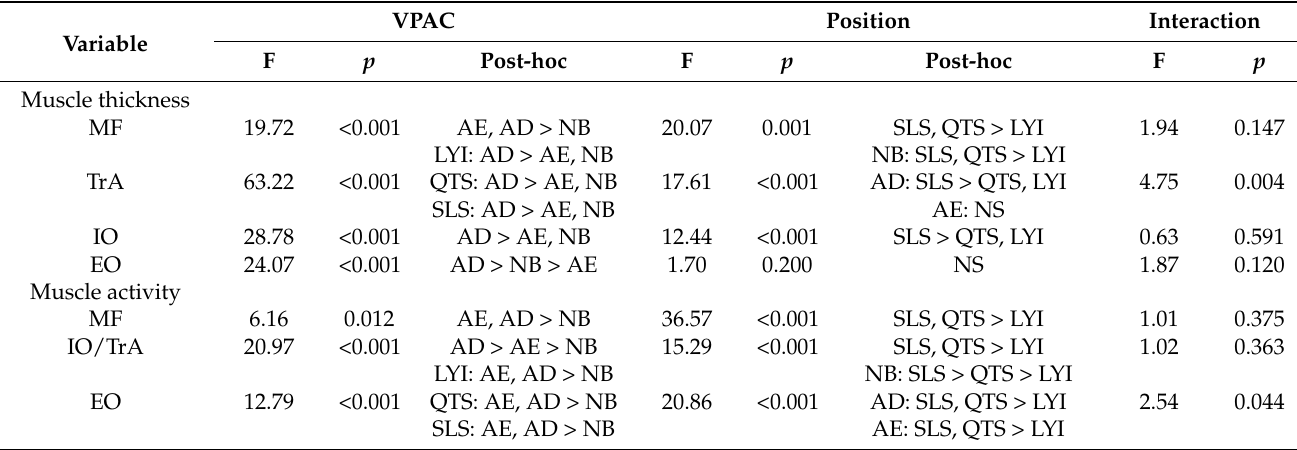
Table 2. Comparisons for the thickness and activity of the lumbar stabilization muscles between different volitional preemptive abdominal contraction (VPAC) strategies and body positions.